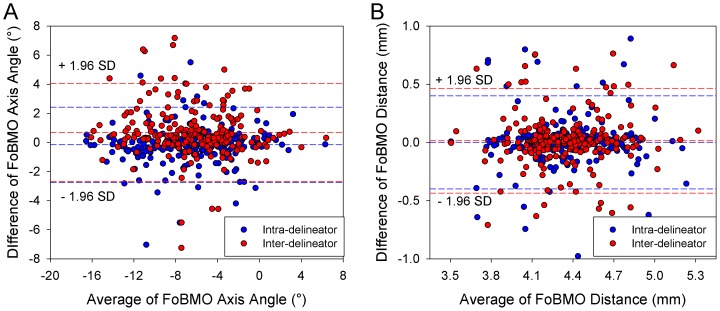
Bland-Altman plots of intra-observer and inter-observer agreement for FoBMO axis angle (A) and FoBMO distance (B).For FoBMO axis angle, intra-delineator limits of agreement (LOA) was −2.8° to 2.4° while inter-delineator LOA was −2.7° to 4.1°. For FoBMO distance, intra-delineator LOA was −439.2 μm to 467.7 μm while inter-delineator LOA was −402.0 μm to 402.7 μm.